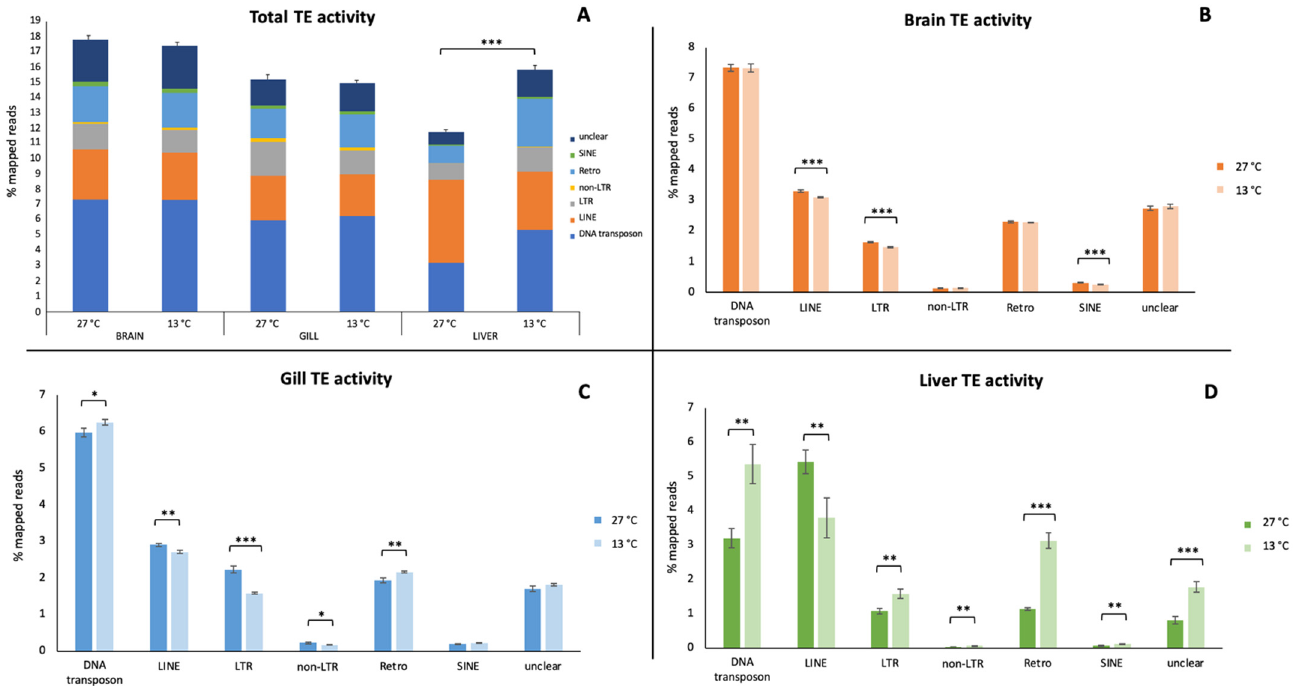
Figure 1. Transcriptional contribution of transposable elements in the brain, gill, and liver in Puntius tetrazona . ( A ) Total TE transcriptional contribution in the three analyzed tissues. ( B ) Transcriptional contribution of each TE type in the brain. ( C ) Transcriptional contribution of each TE type in the gill. ( D ) Transcriptional contribution of each TE type in the liver. Values expressed as the percentage of mapped reads are reported for both tested temperature conditions (27 °C and 13 °C) for each tissue. Statistically significant differences are presented as * for p < 0.05, ** for p < 0.01, and *** for p < 0.001.